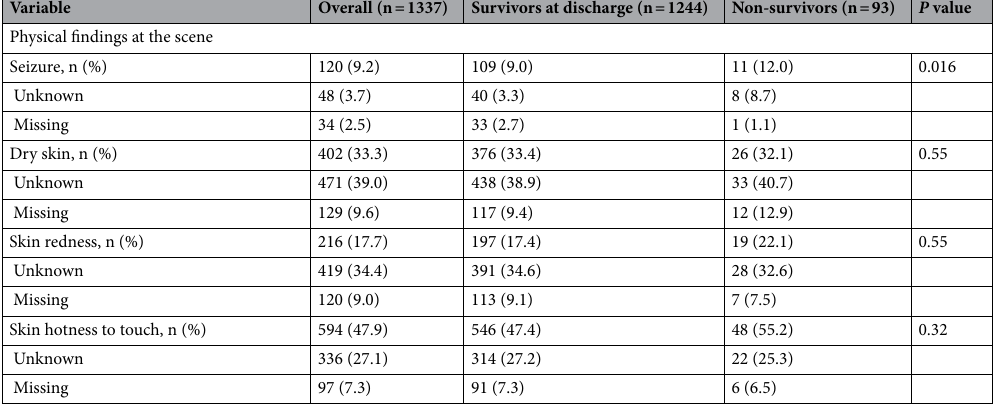
Table 1. Patients’ characteristics. IQR, Interquartile range; SBP, systolic blood pressure; DBP, diastolic blood pressure; PR, pulse rate; RR, respiratory rate; BT, body temperature; GCS, Glasgow coma scale.